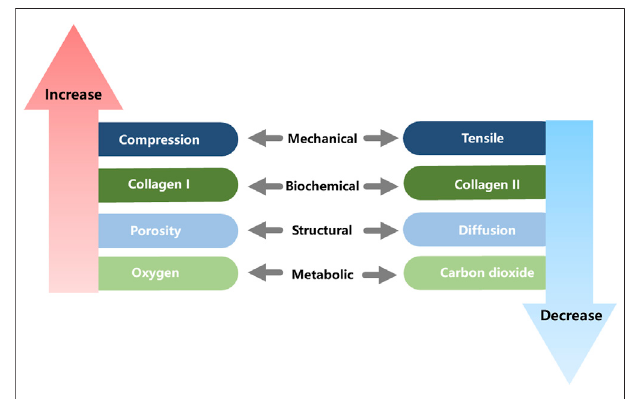
FIGURE 3 | Gradient change of osteochondral